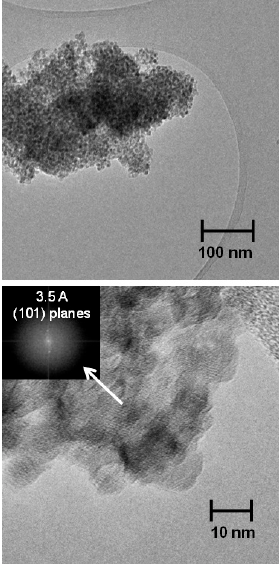
Figure 2. Transmission electron micrographs of the synthesized powders. In the inset of the bottom micrograph a FFT pattern of the periodic arrangement of the crystal planes is shown with an indexing for the trigonal anatase lattice.